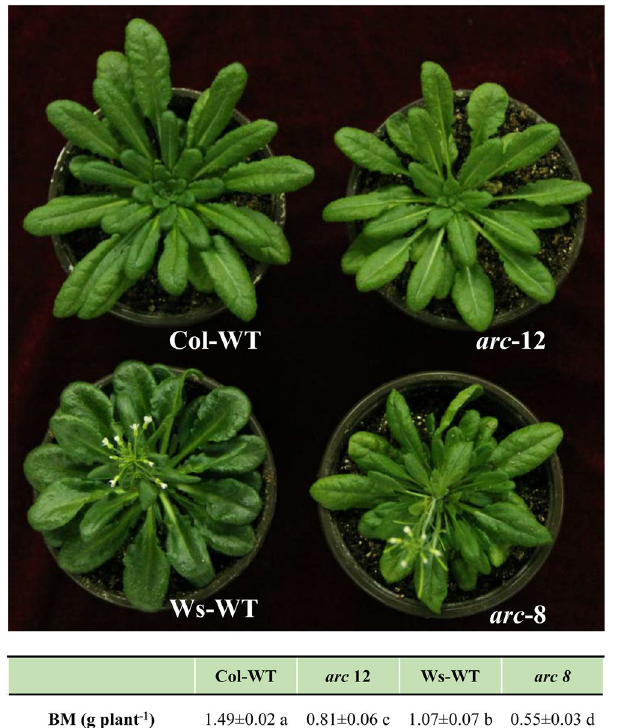
Figure 1. Phenotypes and biomass (BM) of plants 72 days after germination. The BM values shown are the mean ± SD of three replicates. The means were compared with a least significant difference (LSD) test; values followed by the same letter are not significantly different ( P <